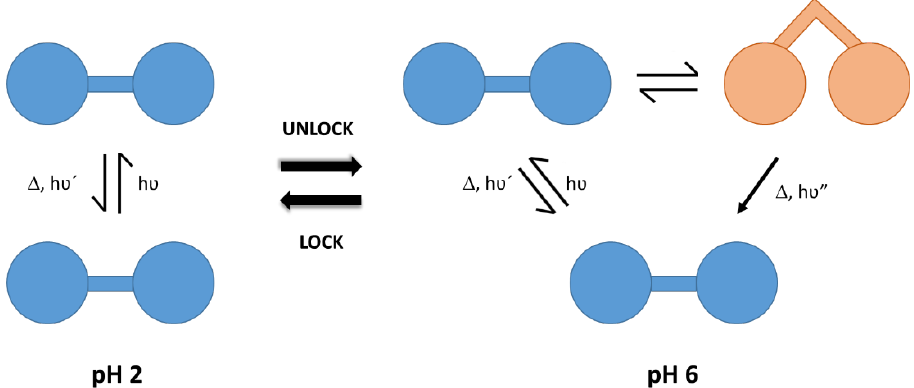
Figure 2. Excimer formation and molecular movement associated to the protonation degree of the polyamine chain acting as spacer between fluorophore groups. Adapted with permission from Ref. [13]. Copyright 2001, The Royal Society of Chemistry.